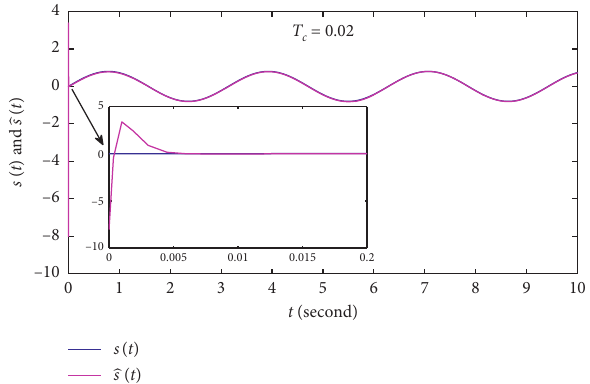
Figure 14: State trajectories of encrypted signal s ( t ) and decrypted signal 􏽢 s ( t ) with T c � 0 .